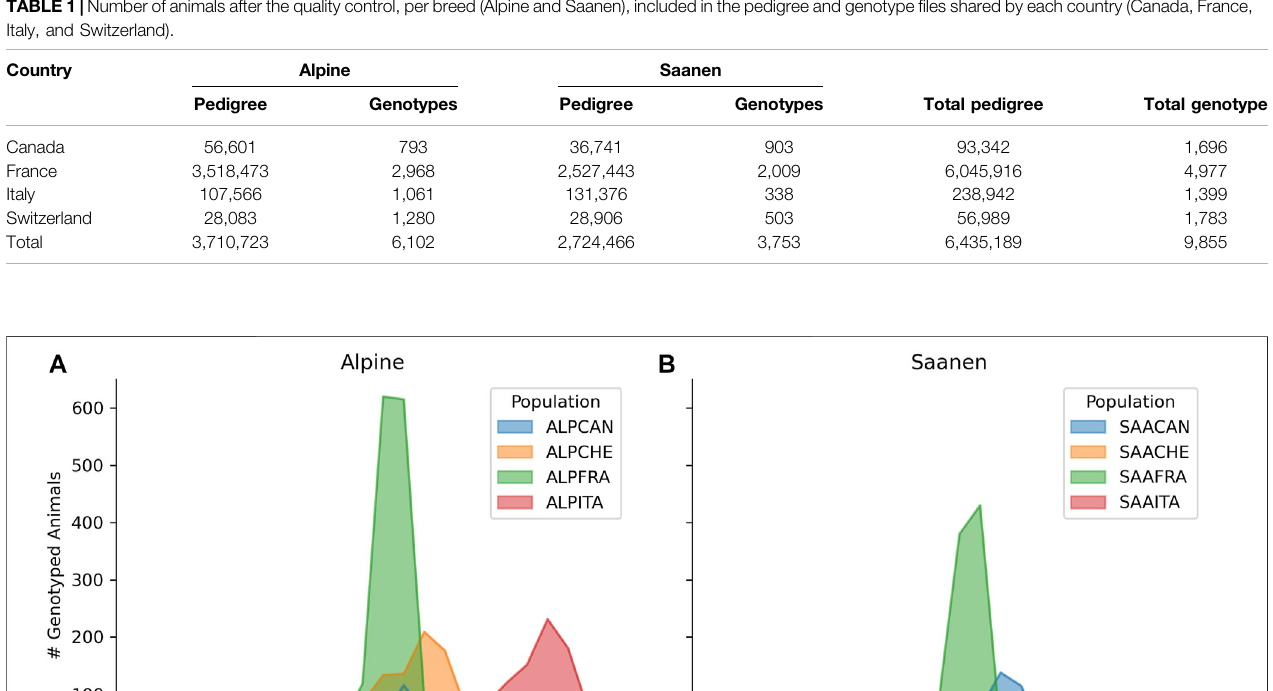
Frontiers in Genetics |